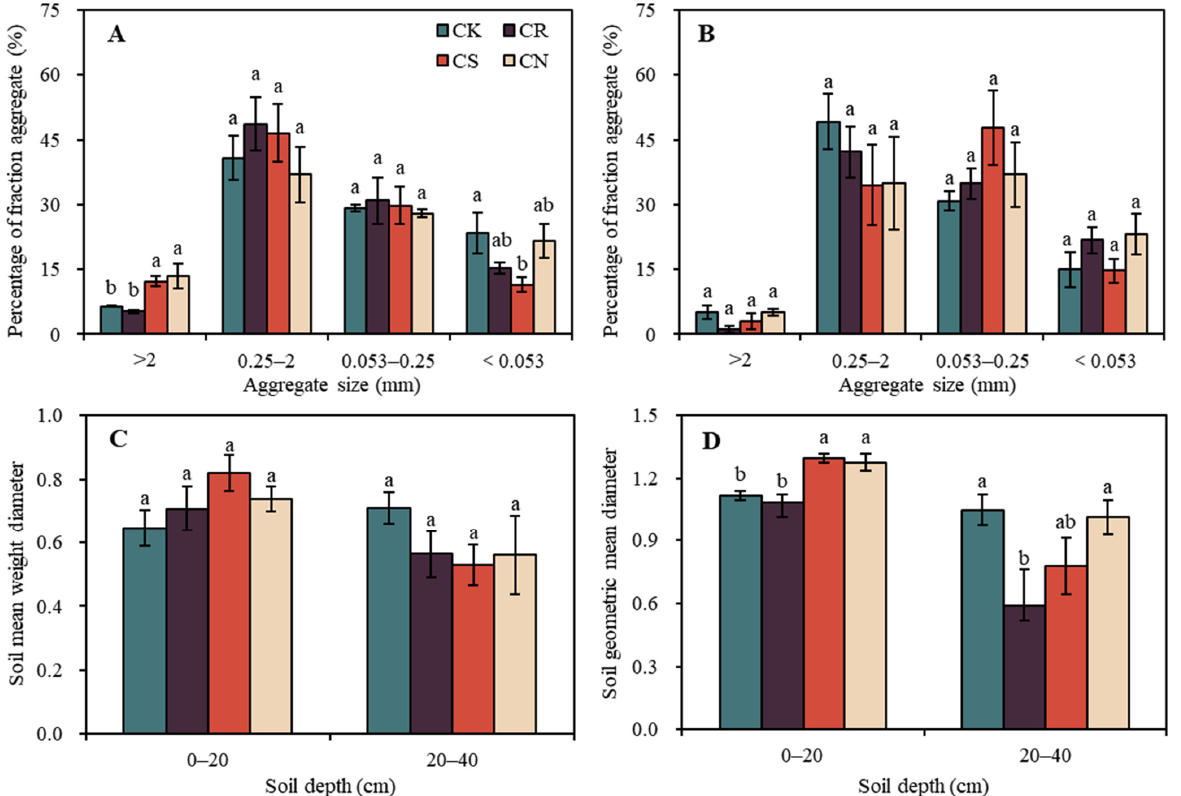
Figure 6. Soil aggregate fractions at the 0–20 cm ( A ) and 20–40 cm ( B ) soil depths, soil mean weight diameter ( C ), and soil geometric diameter ( D ), as affected by tillage regimes in 2021. CK, rotary tillage without straw returning; CR, rotary tillage with straw incorporation; CS, subsoiling tillage with straw mulching; CN, no tillage with straw mulching. Bar means the standard error. Different letters among the treatments for each soil aggregate fractions indicate a significant difference at p < 0.05.